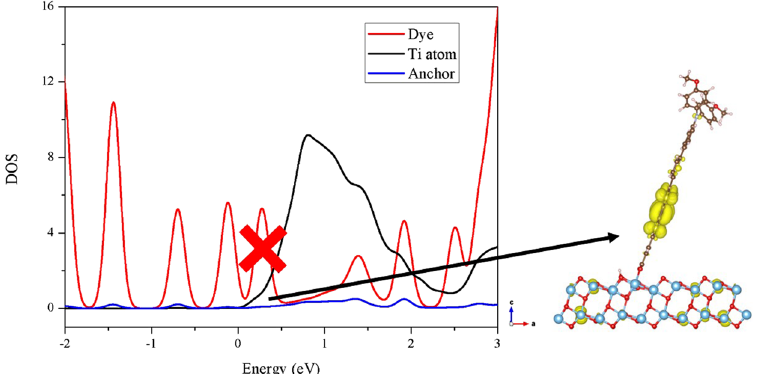
Figure 10. The PDOS along with its partial charge density for the peak at conduction band minimum of dye D π -CDM-COOH adsorbed on TiO 2 surface; isovalue 0.0004 a.u.